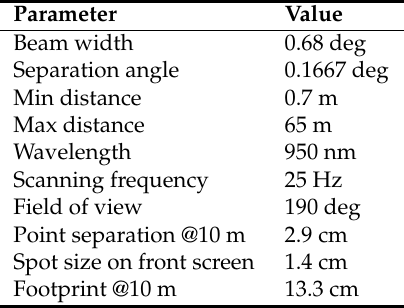
Figure 3. Bird’s eye view of a point cloud colored by line number. Blue, low number; red, high number. Every stem casts a shadow over a curved area, which is occluded from view. Table 2. SICK LMS 511 data of relevance for the used application (high resolution